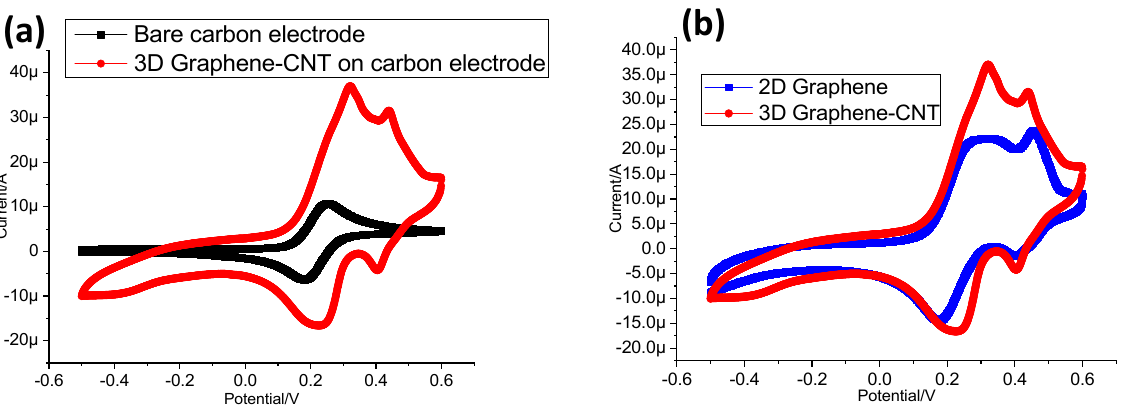
Figure 4. Comparison of the electrochemical surface area of the 3D Graphene–CNT-deposited elec- trode with that of the ( a ) bare carbon electrode and ( b ) 2D Graphene-deposited electrode, respectively. 3.2. Interface Properties of Surface-modified Electrodes The properties of electrodes with different types of modified surfaces were examined by EIS in 0.1 M NH 4 Cl solution. The results of the EIS are illustrated as a Nyquist plot in Figure 5, in which the semicircular portion observed at the higher frequencies corresponds to the electron transfer-limiting process, while the linear portion at the lower frequencies relates to the diffusion-controlled process. The diameter of the semicircular portion can be regarded as an indicator of the electron transfer resistance ( R ct ).